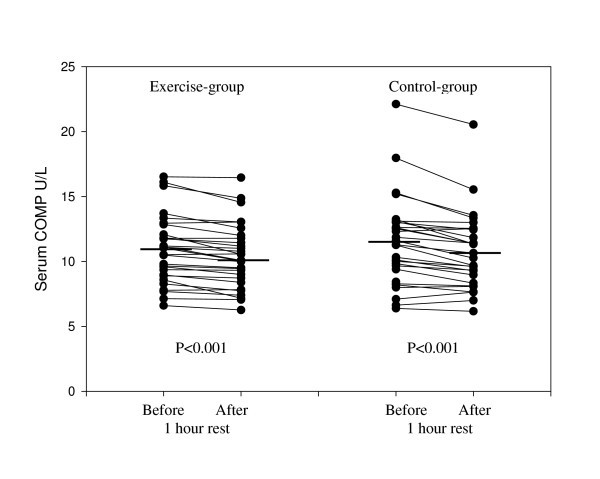
Serum COMP at start of study. Serum concentration of COMP at week -3, before intervention, in study 1. Each line represents an individual patient. Horizontal bars show median values for each group.